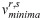
Prediction using cruciality bar-codes described in the section on interaction cruciality for two VP monomers assembling across a hexamer interface in BMV.Each node in the atlas roadmap in the middle represents an active constraint region (macrostate) in EASAL. Example active constraint graphs are shown at far left: the yellow and red circles represent atoms participating in active constraints (interactions) in the two VP monomers. At each successive level, the number of active constraints increases by 1 and the energy level and effective dimension decrease by 1. The atlas nodes in the bottom-most row represent the 0-dimensional, lowest energy, stable assembly configurations; example configurations shown below them. Their total number (for a given interface s, on removal of a given interaction or constraint r) gives νminimar,s in the computation of the cruciality bar-code. Each such configuration together with nearby higher-energy configurations in all of their ancestor nodes constitute one potential energy basin. Their sum, across all basins, weighted by energy level gives the denominator of νcapsidr,s. The rightmost of the stable assembly configurations at the bottom corresponds to the true realization. Above it, the 3 solid configurations and the transparent sweeps around them show the closest configurations to the true realization in successively higher energy regions in its basin (one region each for 3 energy levels shown). To the far left, these sweeps are shown as orange highlights in the corresponding Cayley parameterized regions. The colorful basin plot shows the total weighted configurations in the true basin, stratified by dimension or energy level. Their sum is the numerator of νcapsidr,s.